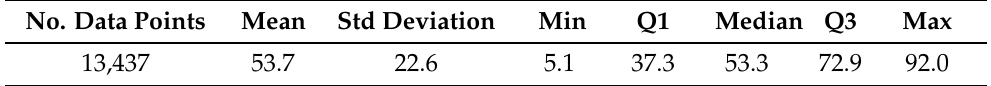
Table 3. Statistical summary of tilt angle.